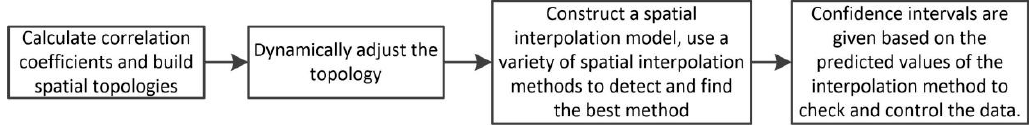
Figure 7. The discrete hydrological data control flow chart.